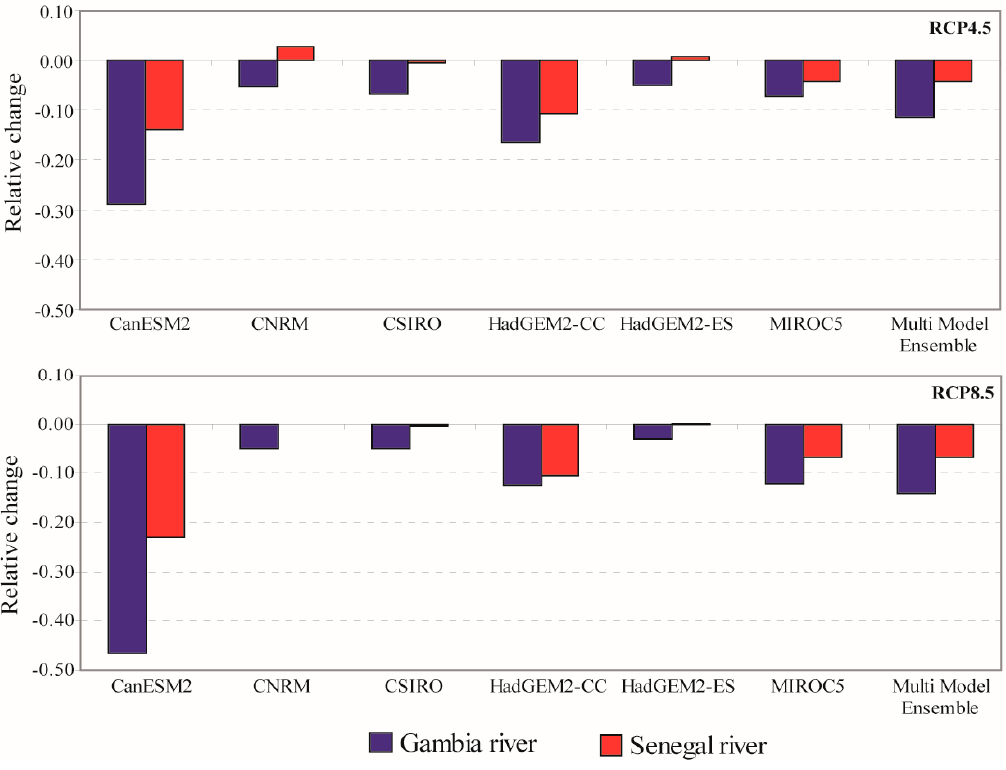
Figure A1. Relative change of annual rainfall in the two river basins under RCP4.5 and RCP8.5.